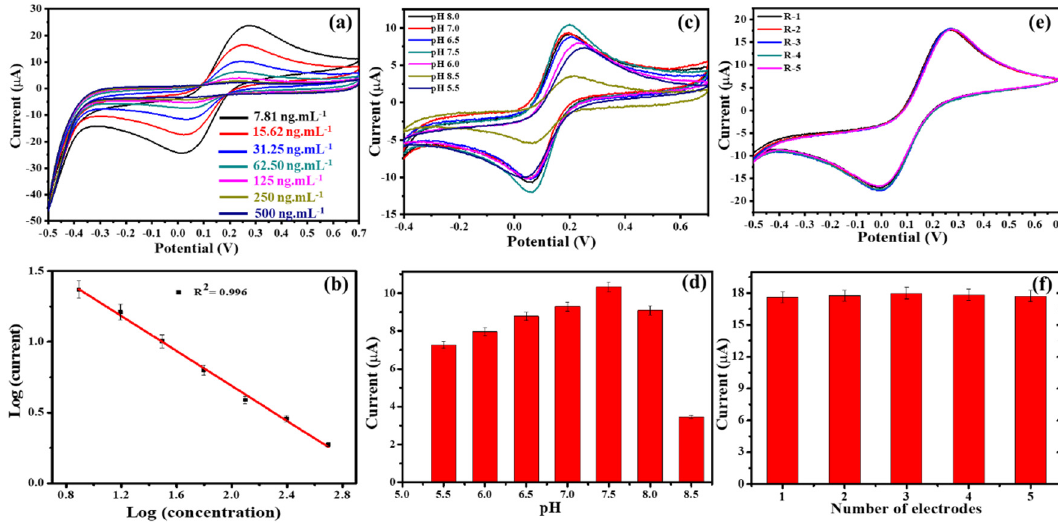
Figure 4. ( a ) Cyclic voltammograms from Fer/Fer Ab /NH 2 -GO@SPCE in presence of ferritin (7.81–500 ng·mL − 1 ). ( b ) Logarithmic plot of ferritin concentration versus obtained current. ( c )